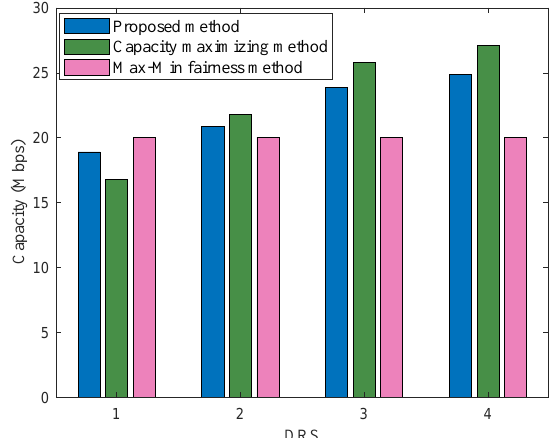
Figure 6. Capacity distribution for 4 DRSs in scenario 1.